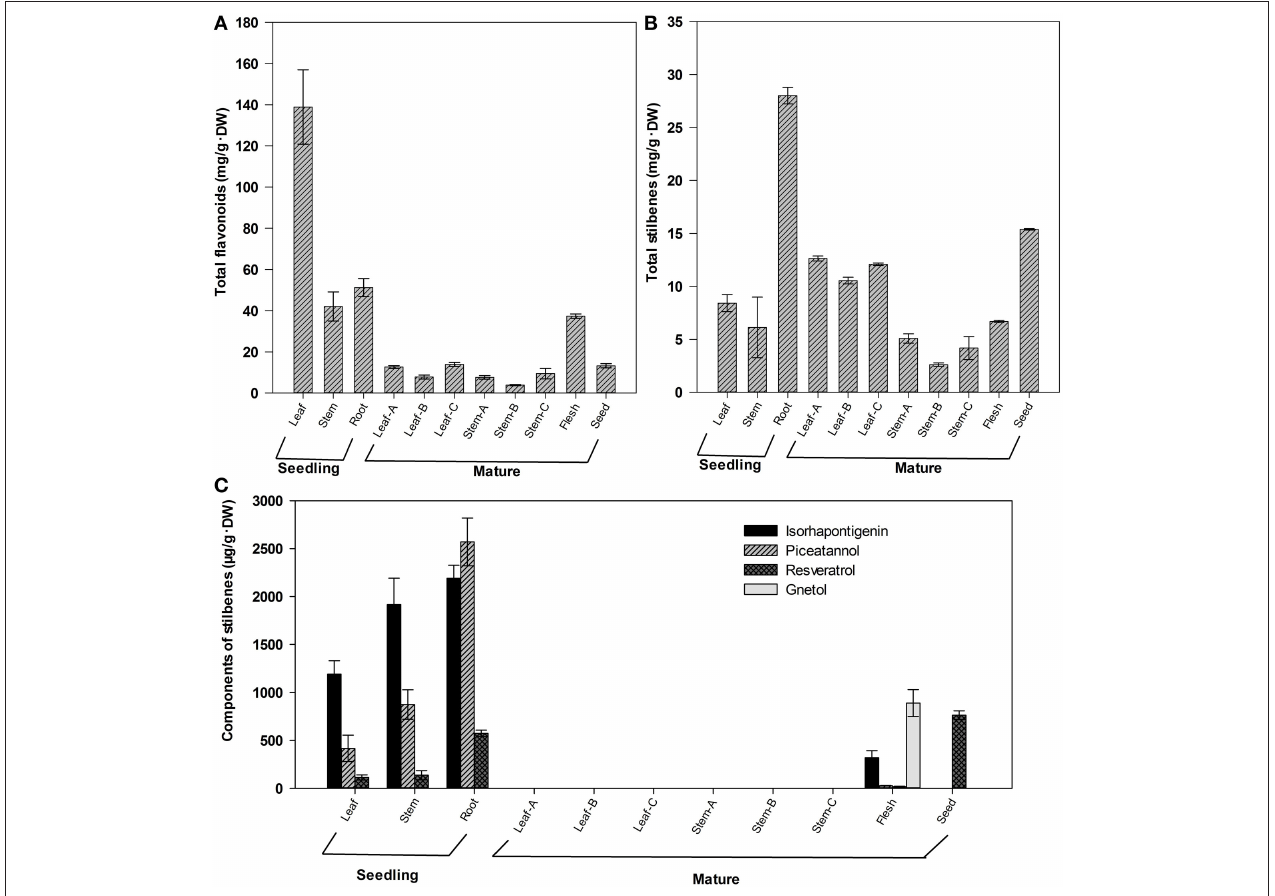
FIGURE 1 | Contents of total flavonoids and total stilbenes in different tissues of Gnetum parvifolium . (A) Total flavonoids; (B) Total stilbenes; (C) Component of stilbenes. Vertical bars represent the mean ± SD of four separate experiments. In figure, Leaf, Stem, and Root were collected from 1-year old seedlings; Leaf/Stem-A, -B, and –C were three stages of leaves/stems from young to old, respectively, collected from mature trees in September; Flesh and Seed were fruit flesh (aril) and seeds,